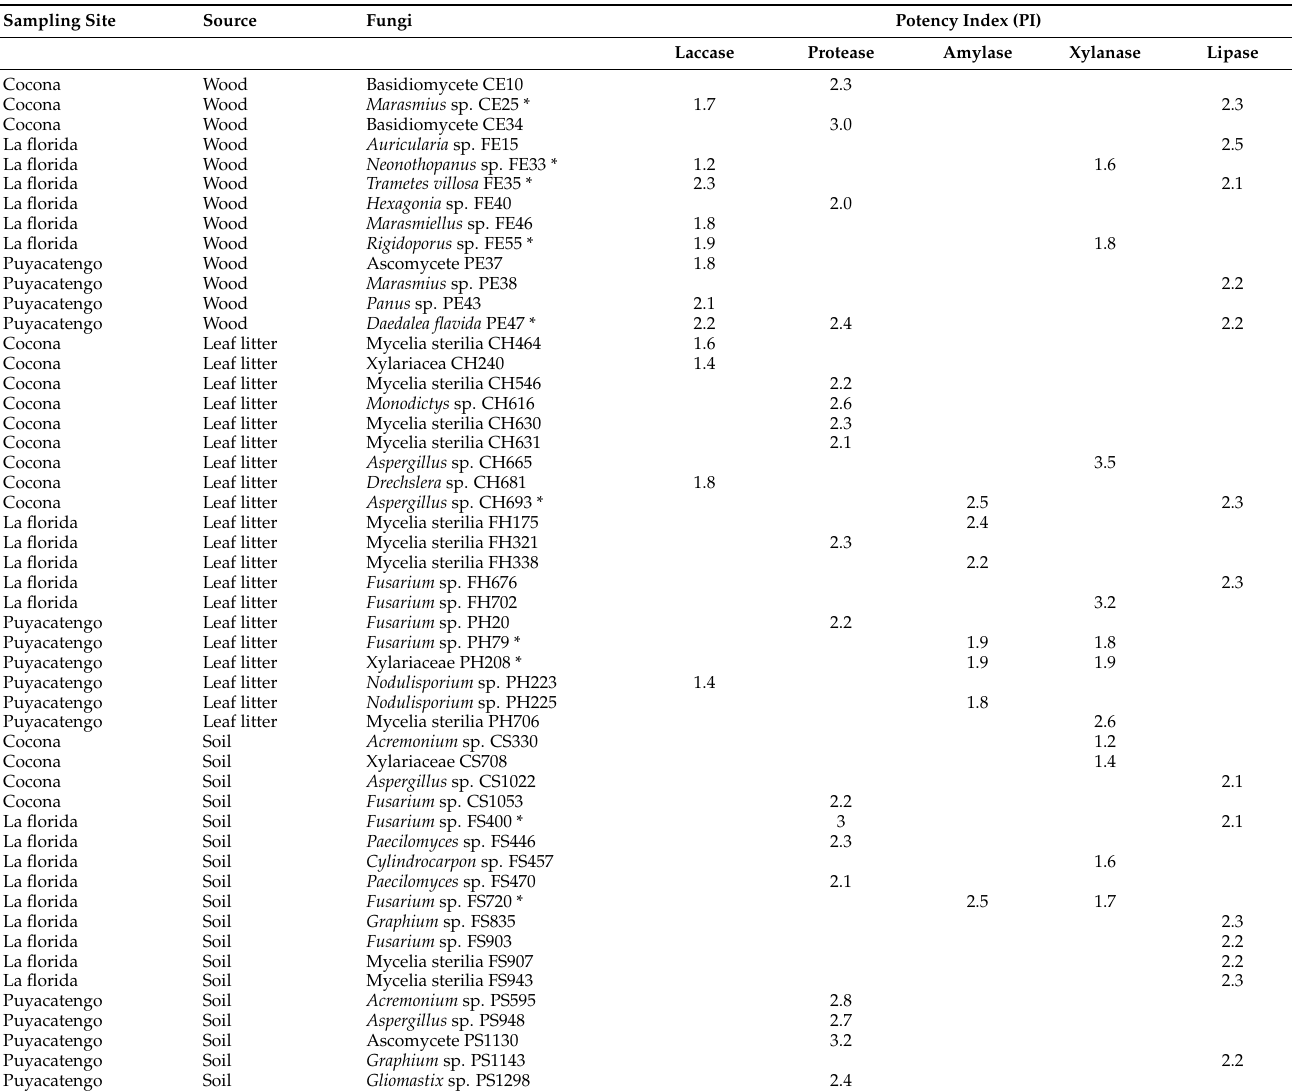
Table 1. Primary enzymatic screening of different extracellular enzymes produced by fungal strains isolated from Sierra de Tabasco,